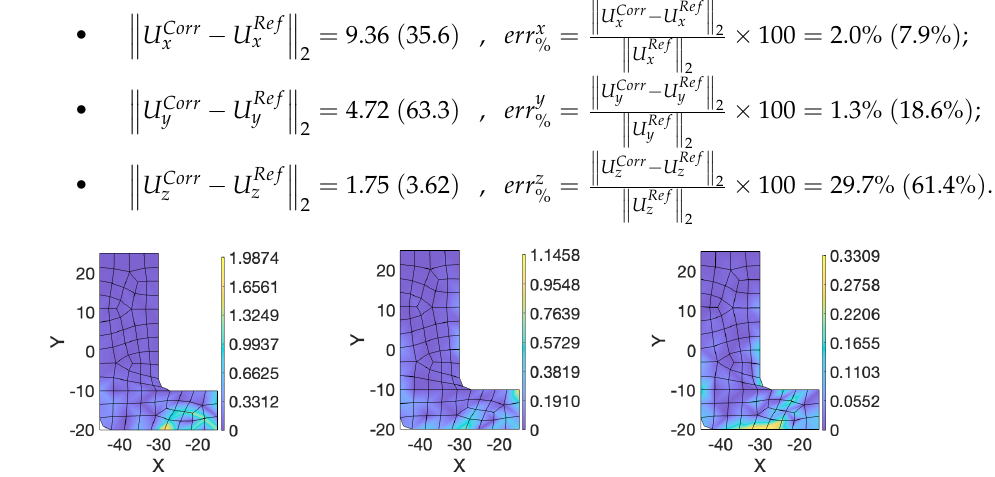
Figure 17. Top view of the difference in absolute value between the corrected and the reference displacement field, for x ( left ), y ( middle ) and z ( right )